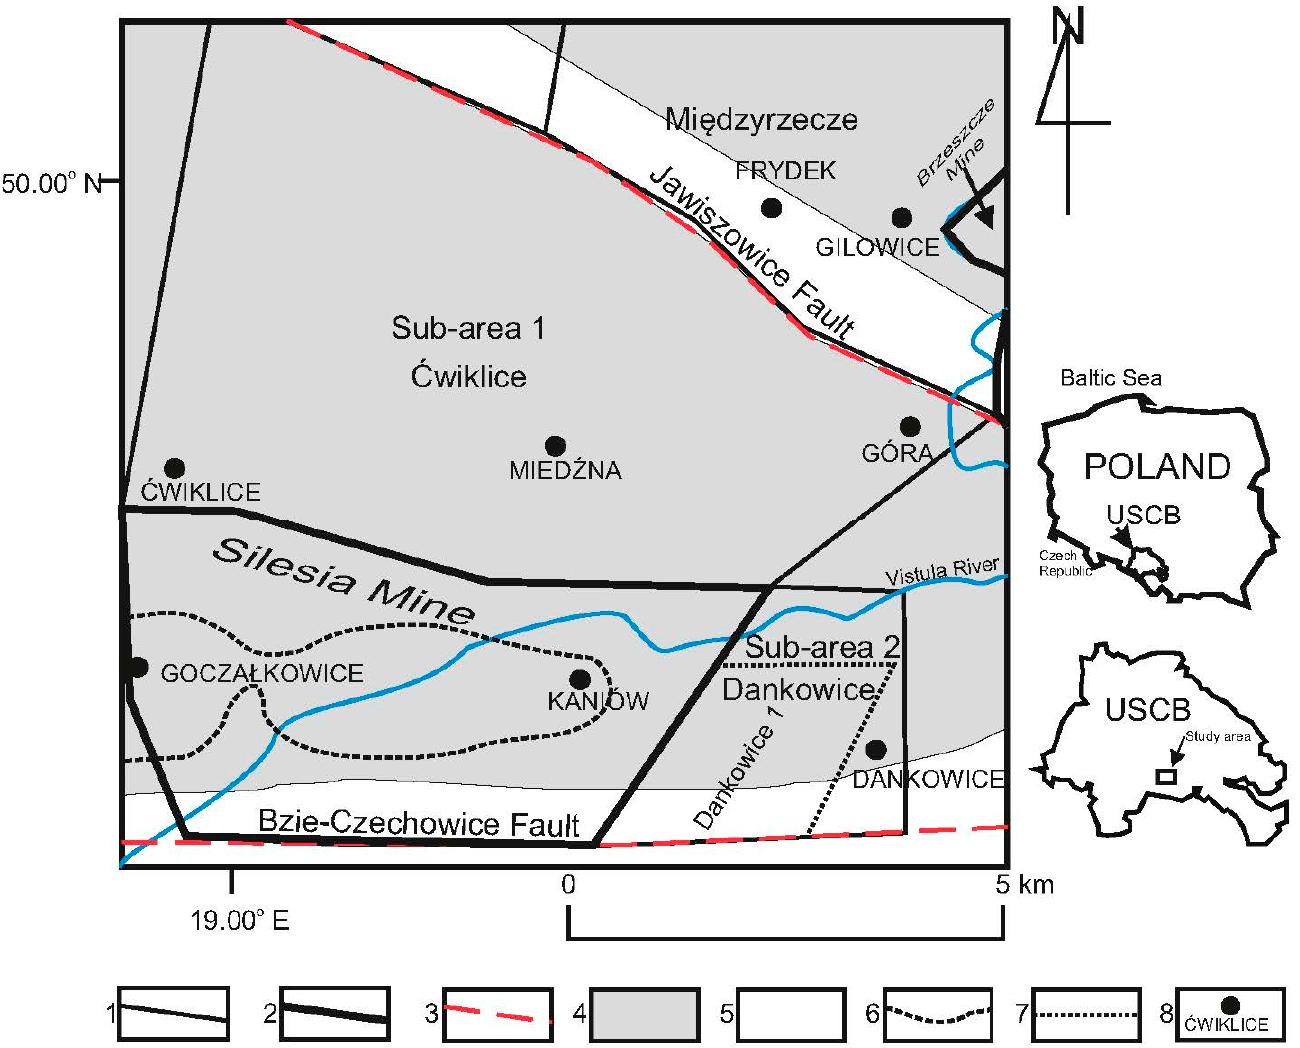
Figure 1. Location of the ´Cwiklice and Dankowice sub-areas; 1—boundaries of coal fields, 2—boundaries of working mines, 3—important faults, 4—Cracow Sandstone Series, 5—Mudstone Series, 6—boundaries of free methane deposit “Silesia”, 7—boundaries of Silesia 1 area with planned coal and methane exploitation, 8—important towns.